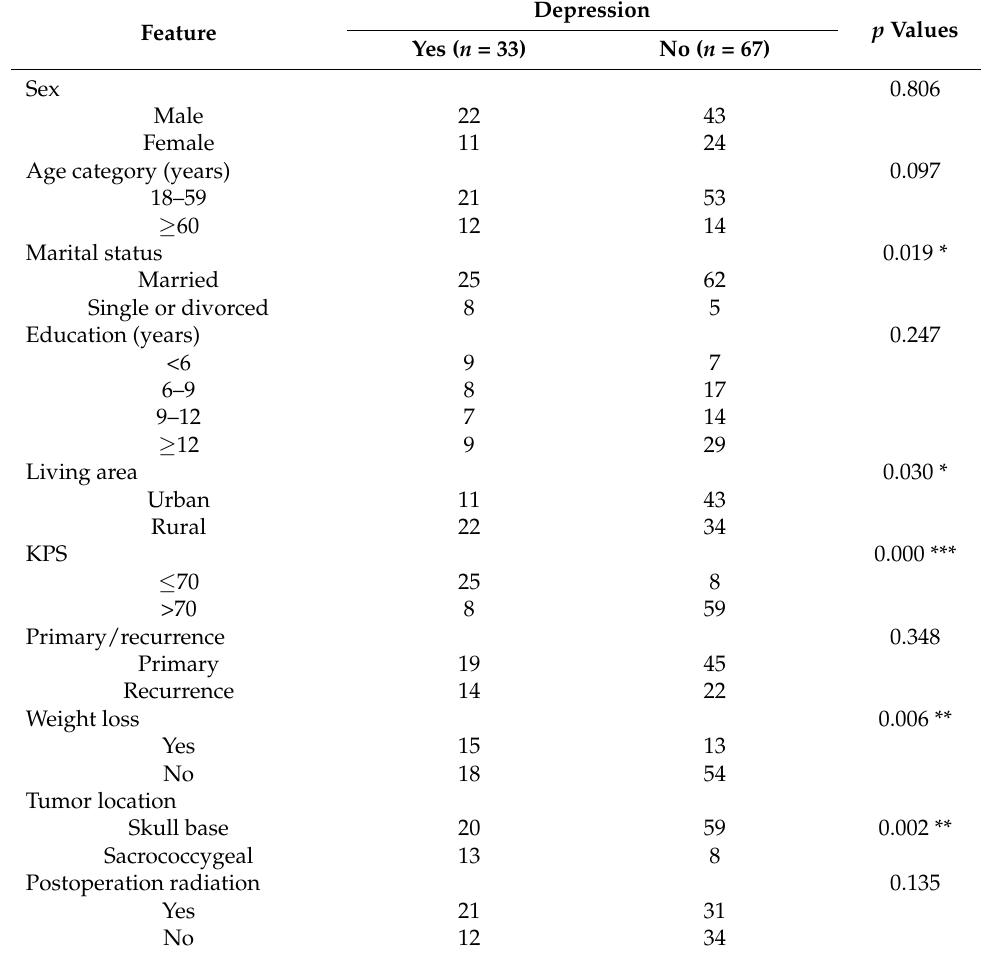
Table 2. Characteristics of 100 patients with chordoma.